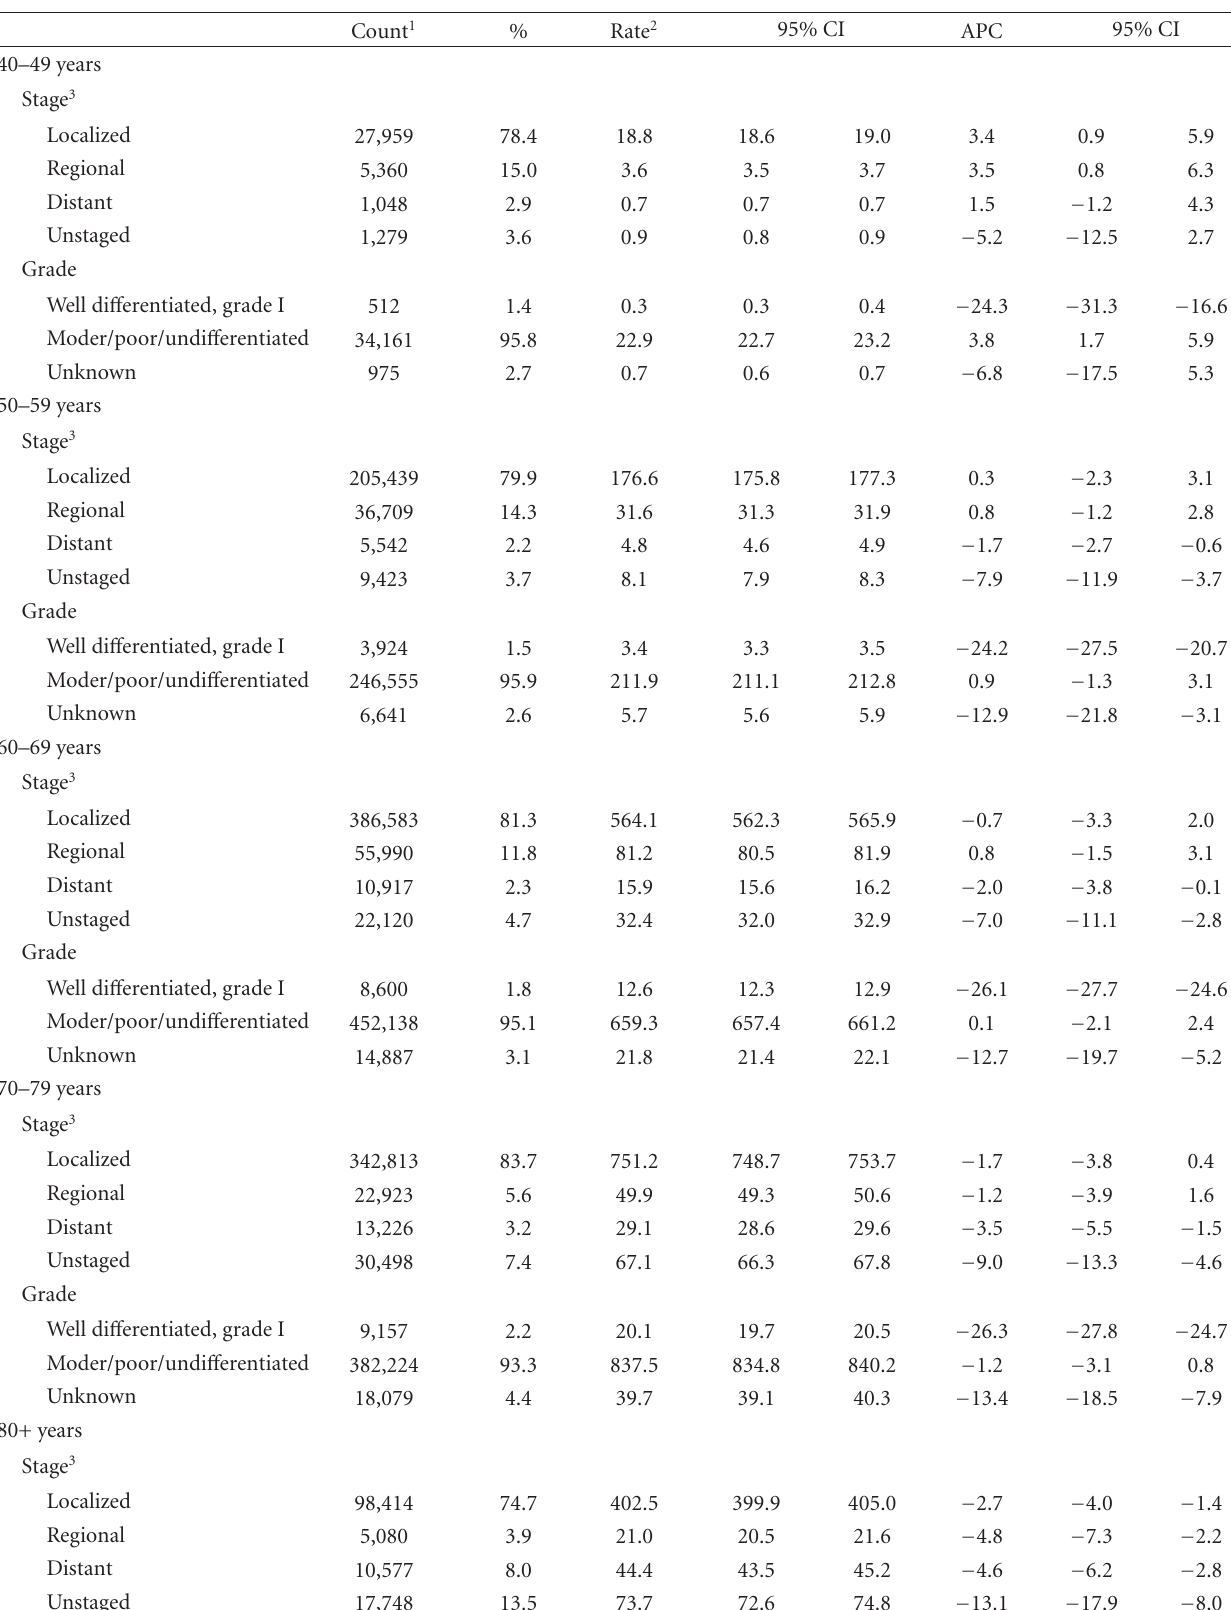
Table 2: Incidence rates and annual percentage changes in rates for prostate cancer by age, stage, and grade, US men over 40 years, 2001–